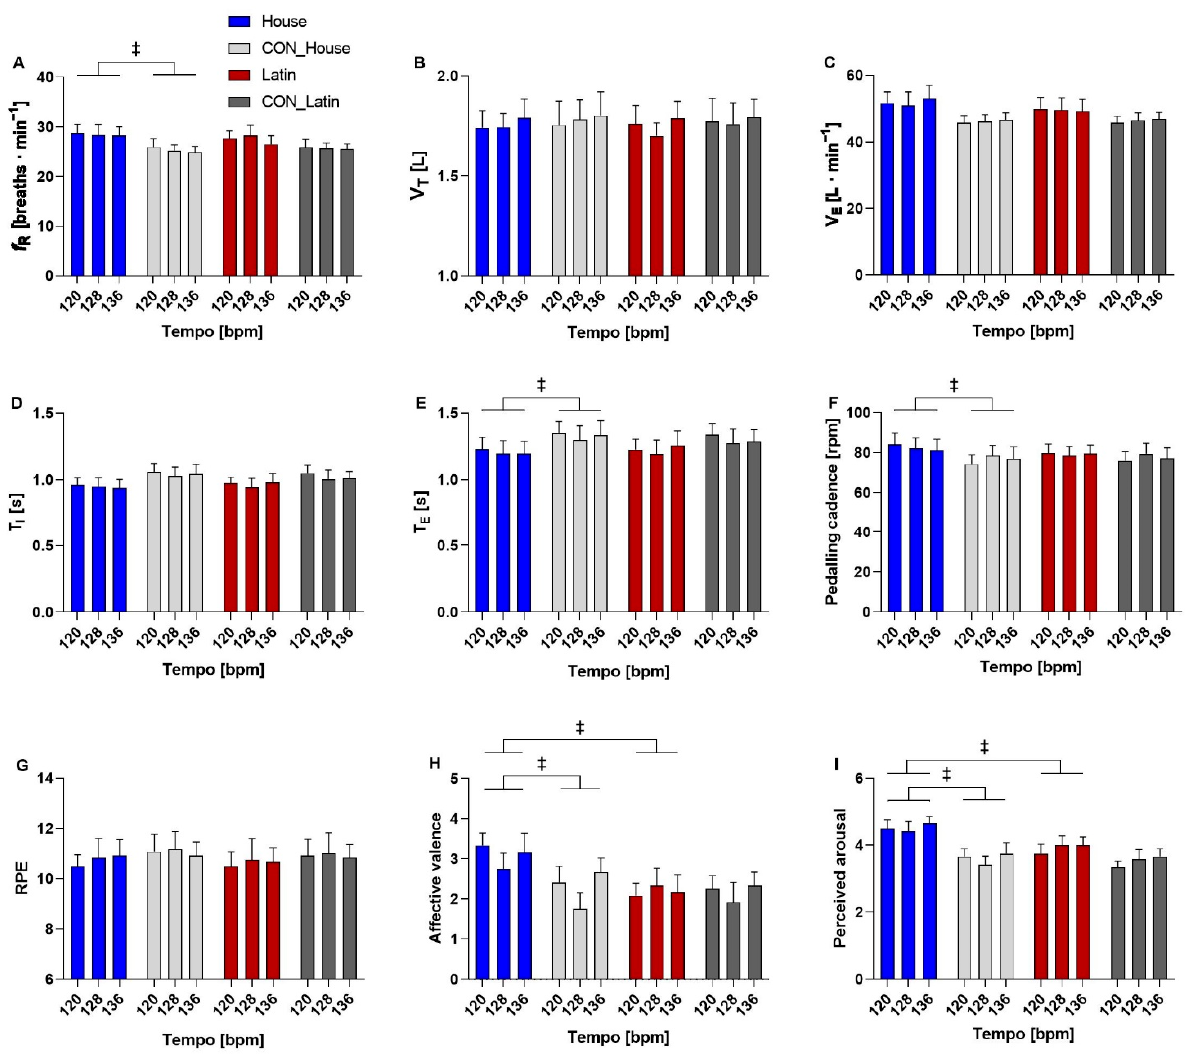
Figure 9. Comparison between House and control conditions (CON_House), Latin and control conditions (CON_Latin), and House and Latin conditions for respiratory frequency ( A ), tidal volume ( B ), minute ventilation ( C ), inspiratory time ( D ), expiratory time ( E ), pedaling cadence ( F ), rating of perceived exertion ( G ), affective valence ( H ), and perceived arousal ( I ). ‡ main e ff ect of condition ( p < 0.05).